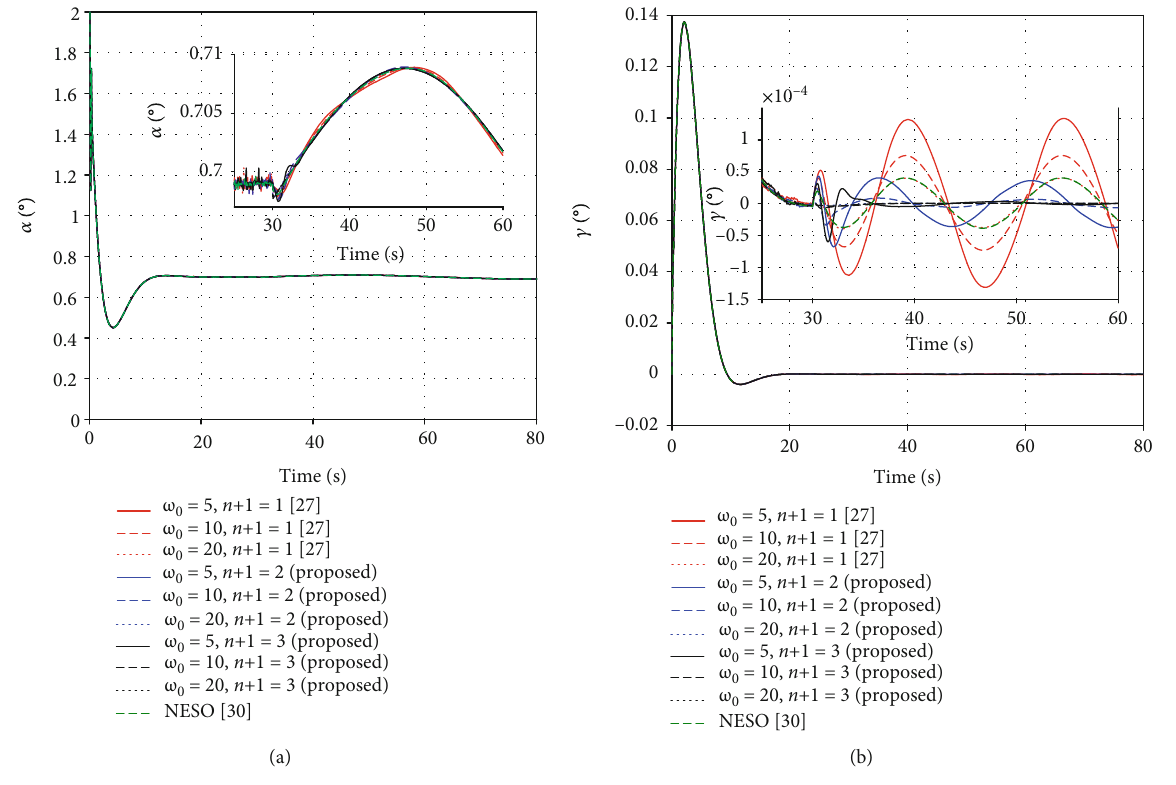
Figure 8: Parametric response curve: (a) attack angle; (b) track